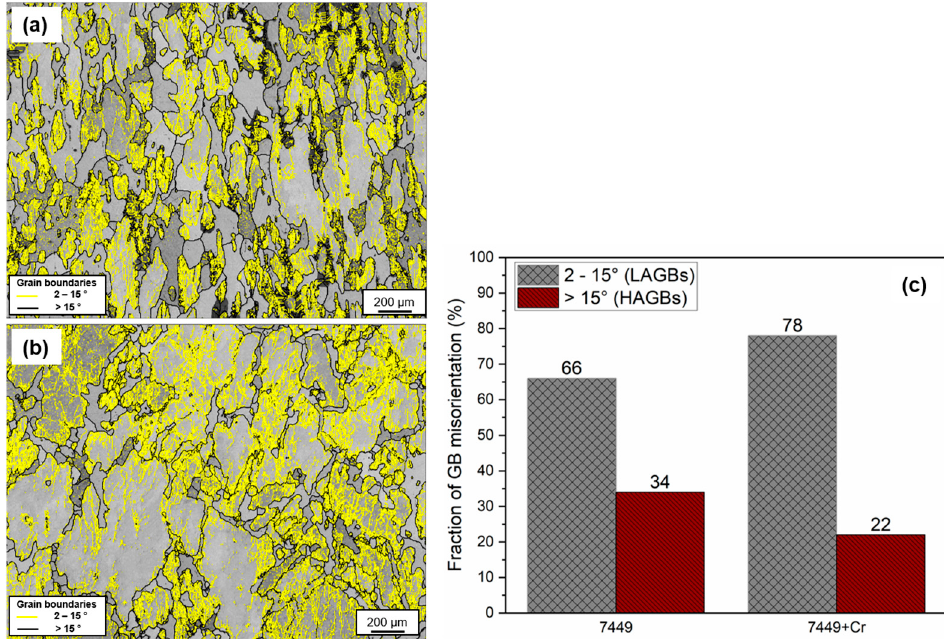
Figure 6. Grain-boundary misorientation in T4 state: ( a ) 7449 and ( b ) 7449+Cr. ( c ) Fraction of LAGBs and HAGBs.